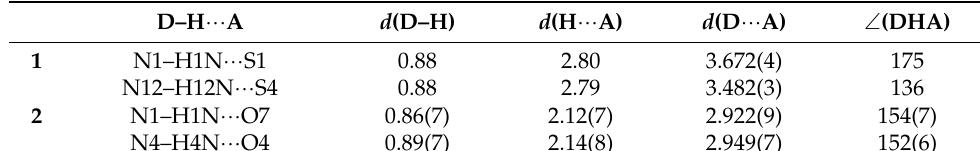
Table 2. Hydrogen Bond Lengths (Å) and Angles (°) for 1 and 2 .